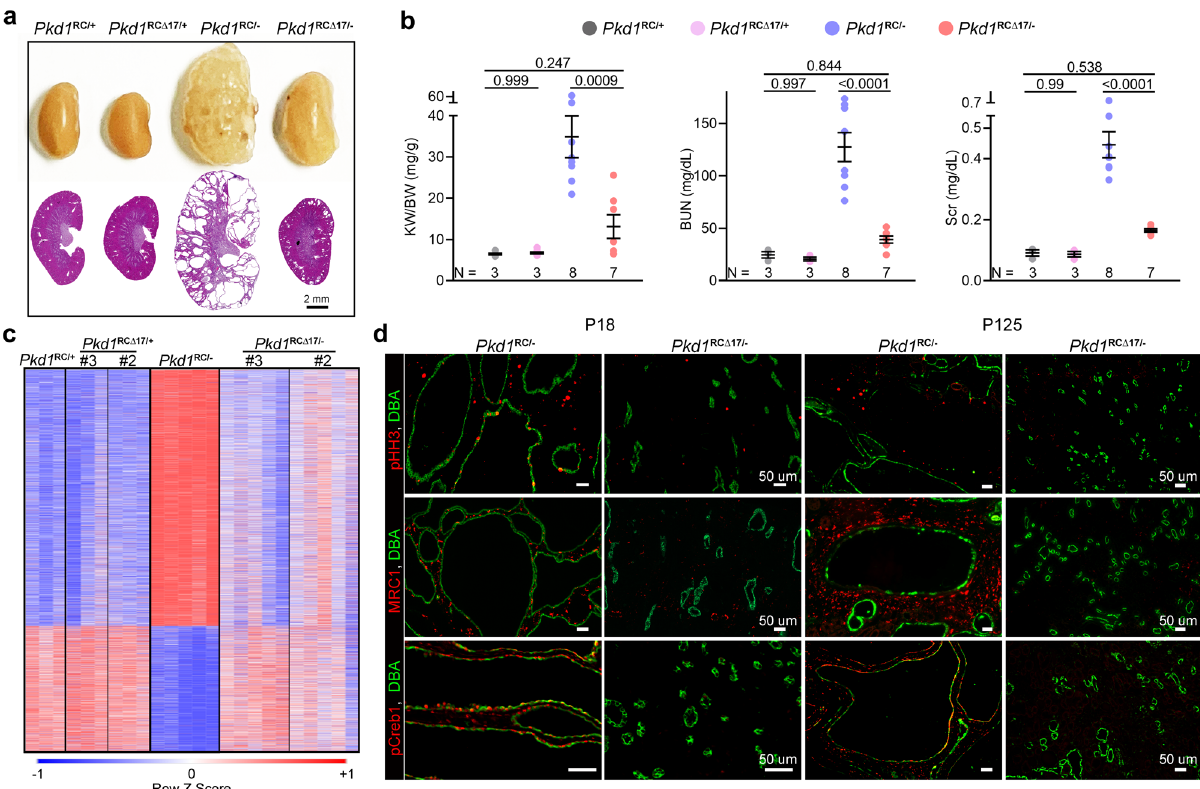
Pkd1 RC Δ 17/- kidneys were chosen for visualization. #3 = founder#3; #2 = founder#2. n =3 ( Pkd1 RC/+ ), n =3 ( Pkd1 RC Δ 17/+ founder 2), n =3 ( Pkd1 RC Δ 17/+ founder 3), n =5 ( Pkd1 RC/- ), n =5 ( Pkd1 RC Δ 17/- founder 2), and n =5 ( Pkd1 RC Δ 17/- founder 3). ( d ) Repre- sentativeimagesshowingphospho-Histone-H3(pHH3),Mannose ReceptorC-Type 1 (MRC1), or pCreb1 immunostaining in kidney sections of18-day-old and 18-week- old Pkd1 RC/- ( n =5)and Pkd1 RC Δ 17/- ( n =5)mice.Thesectionswereco-labeledwithDBA to mark collecting duct-derived cysts. Error bars indicate SEM. Statistical analysis: One-way ANOVA, Tukey ’ s multiple-comparisons test ( b ). Source data are provided as a Source Data fi